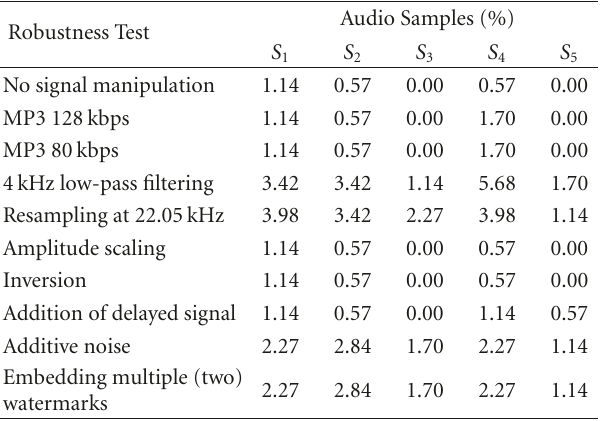
Table 5: Bit error rate (in percentage) for 5 di ff erent music signals under di ff erent signal manipulations.